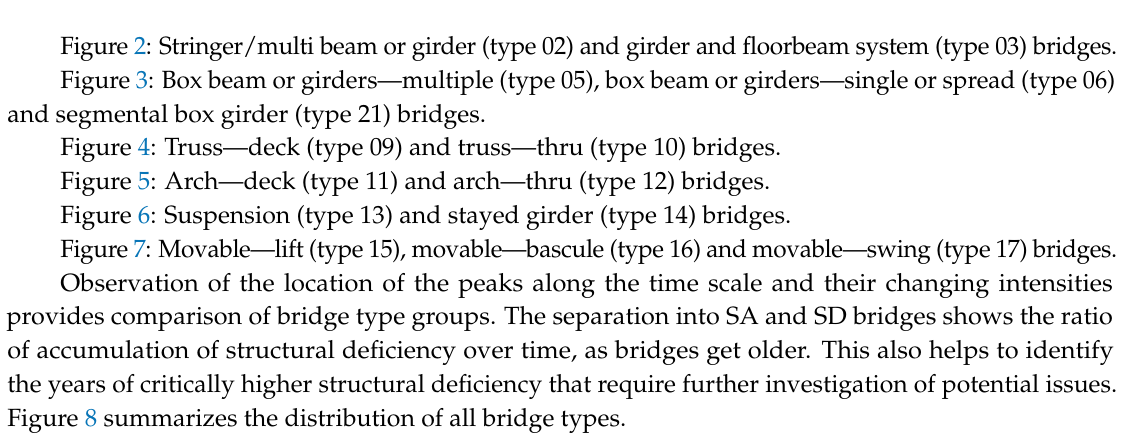
Figure 2: Stringer/multi beam or girder (type 02) and girder and floorbeam system (type 03) bridges. Figure 3: Box beam or girders—multiple (type 05), box beam or girders—single or spread (type 06) and segmental box girder (type 21) bridges. Figure 4: Truss—deck (type 09) and truss—thru (type 10) bridges. Figure 5: Arch—deck (type 11) and arch—thru (type 12) bridges. Figure 6: Suspension (type 13) and stayed girder (type 14) bridges. Figure 7: Movable—lift (type 15), movable—bascule (type 16) and movable—swing (type 17) bridges.